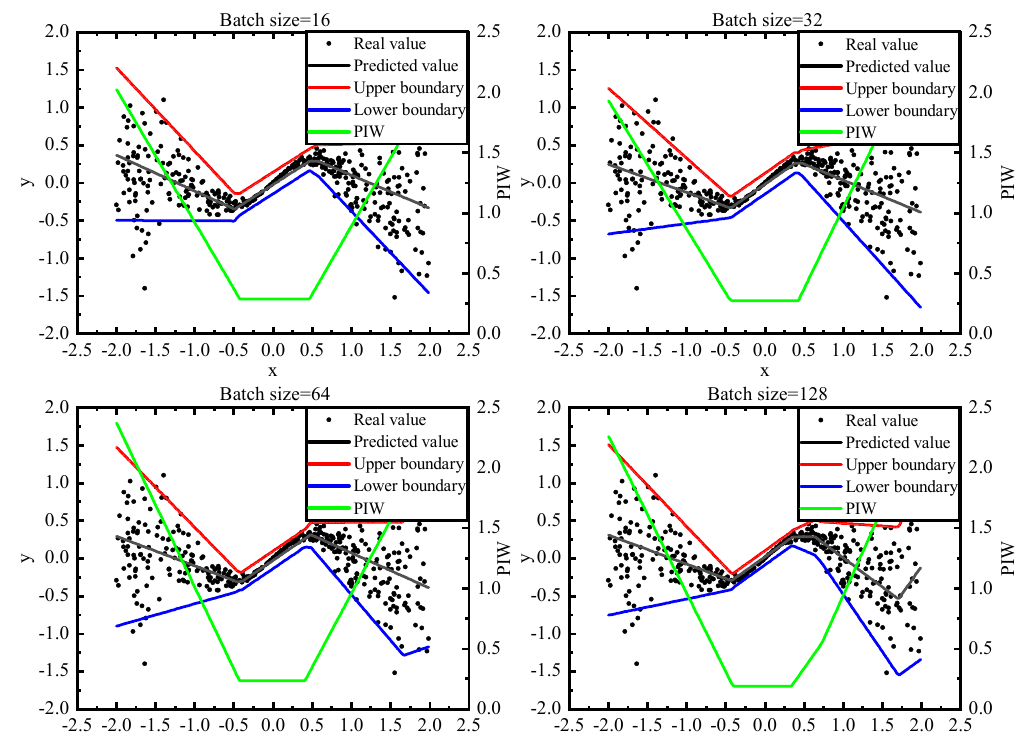
Figure 2. Comparison of PI boundaries for the AB loss by changing the batch size. The upper and lower boundaries are the predicted 95% PIs. The predicted value is generated by the prediction network in the framework.